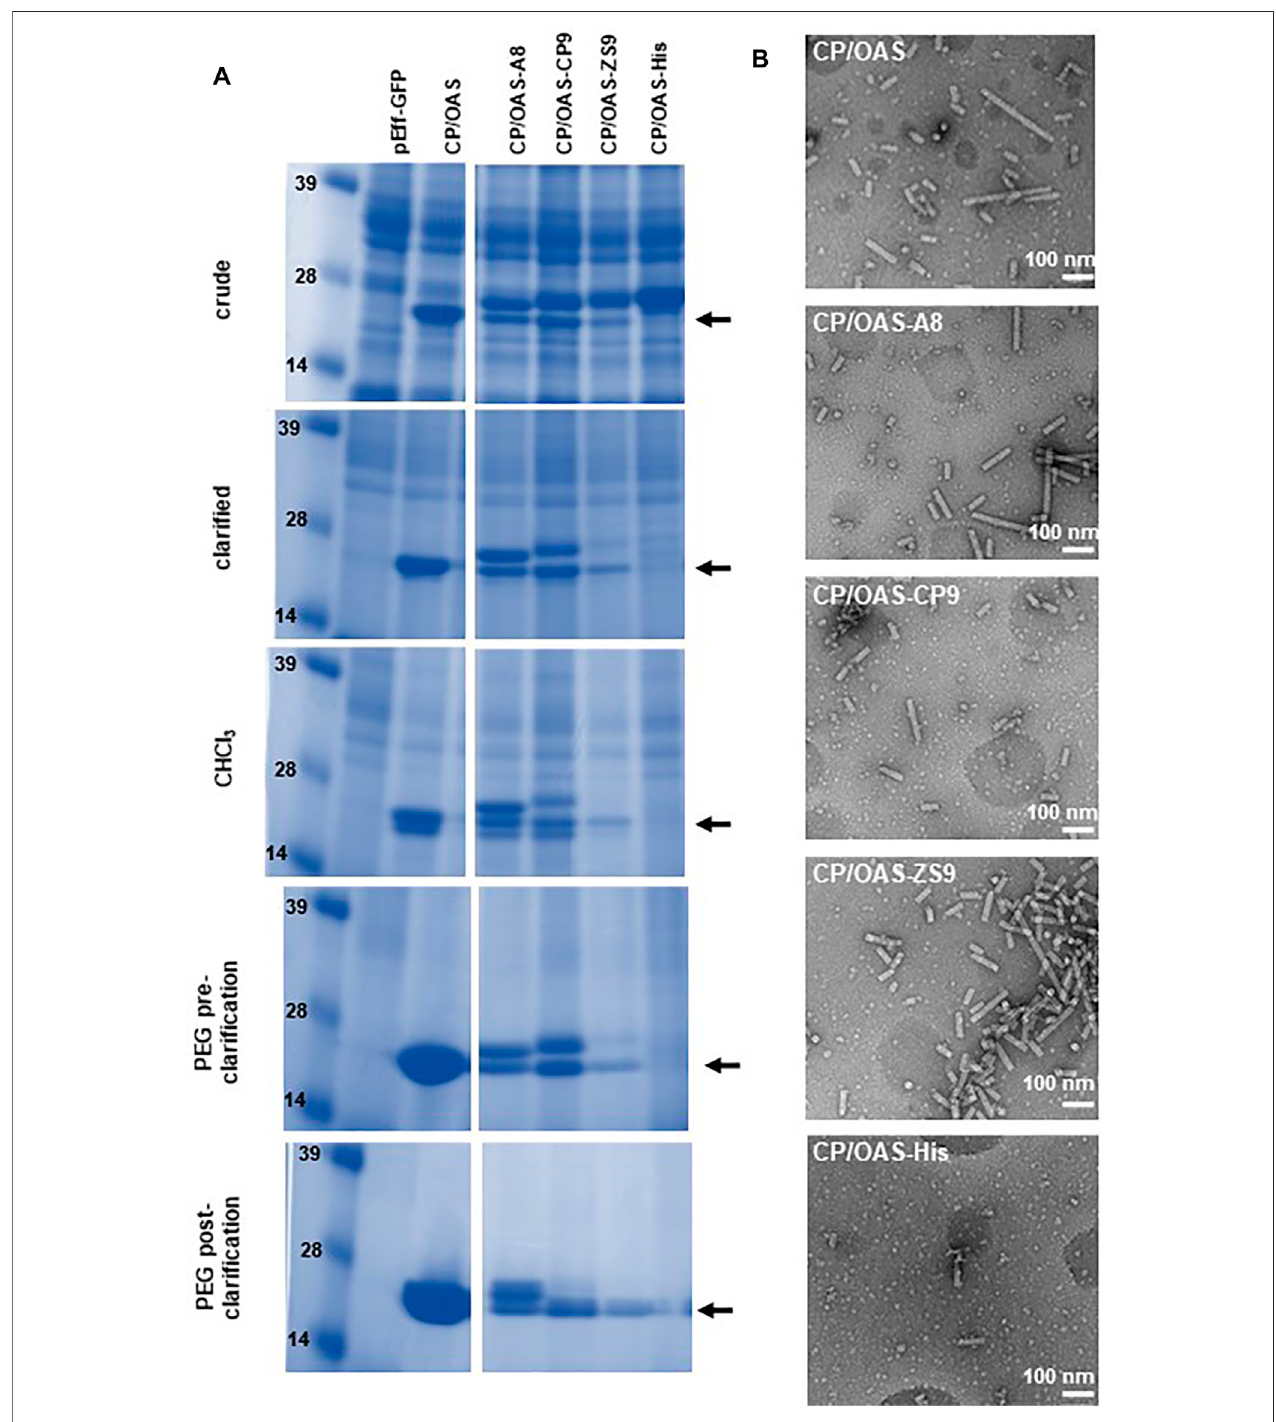
FIGURE4| pEffexpressionofcoat-proteinvariants. (A) InstantBluestainedNuPAGE-MOPSgelelectrophoresis ofwild-typeandvariantCPsatdifferentstagesof the nanorod puri fi cation process as indicated. Further details can be found in Supplementary Figure S2 . The position of wild-type CP is indicated by an arrow. All variant CPs resolve above this band. (B) Transmission electron microscopy images of 118,00 x g pellets. Scale bar = 100 nm. Nanorod samples are indicated in each panel.